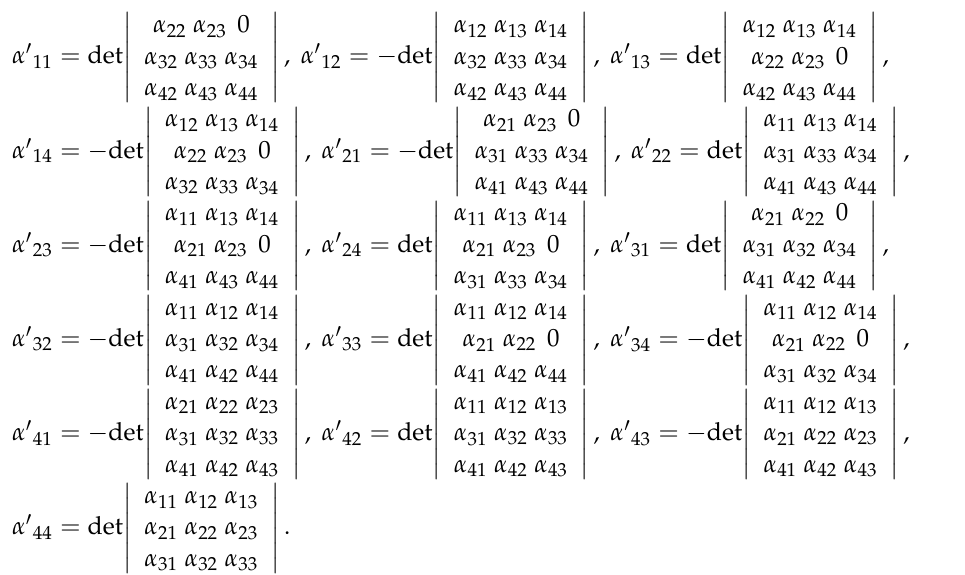
Figure A2. Various stable solutions for mOlig2 (solid line), miRNA, mSox9 and mSox10 (solid line) arising from system (1) when